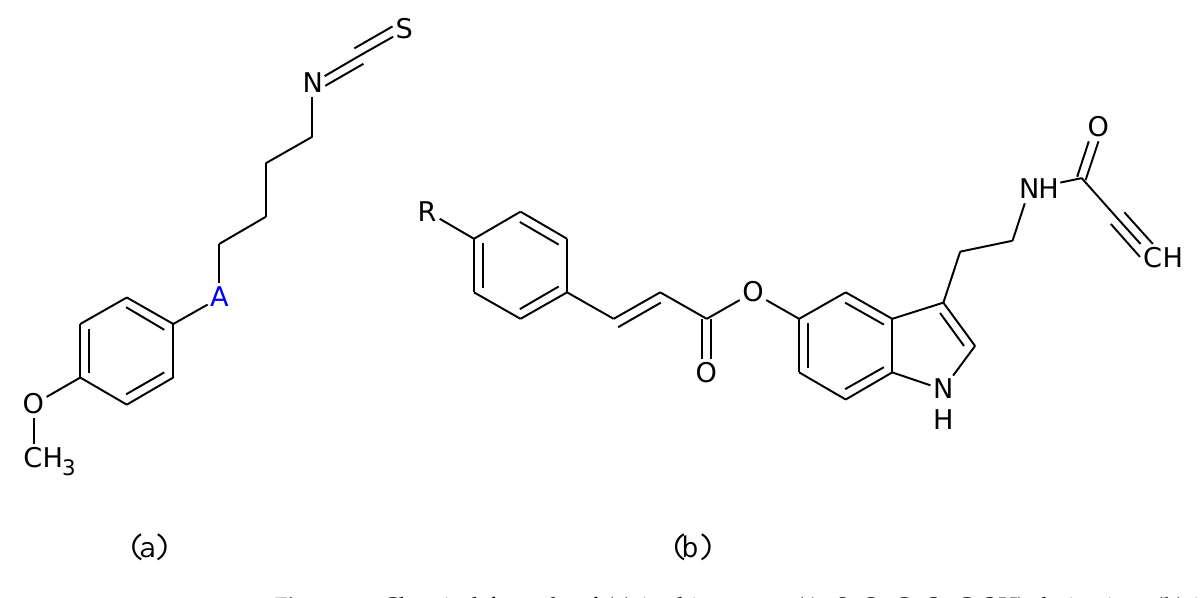
Figure 8. Chemical formula of ( a ) isothiocyanate (A: S=O, C=O, C-OH) derivatives ( b ) indole derivatives (R: H or CH 3 ).